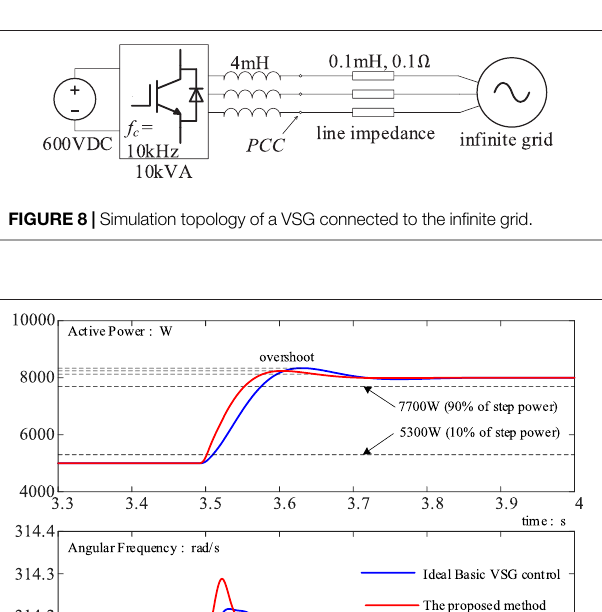
FIGURE 10 | Simulation topology of two VSGs sharing power in islanding.